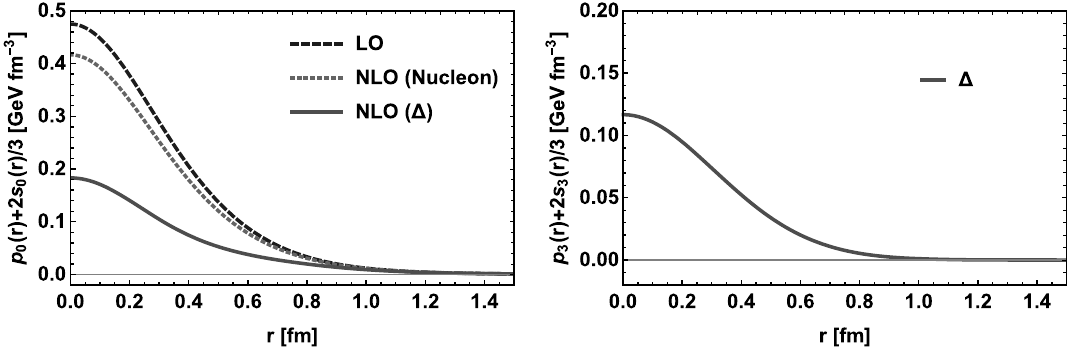
Fig. 5 Theleftpaneldepictstheresultsforthemonopolenormalforces p 0 ( r ) | reconst + 2 s 0 ( r ) , given in Eq. (34), acting on the radial area ele- 3 ment, and simultaneously shows local stability condition in Eq. (36) for the classical soliton, nucleon and unpolarized (cid:2) . The right panel shows